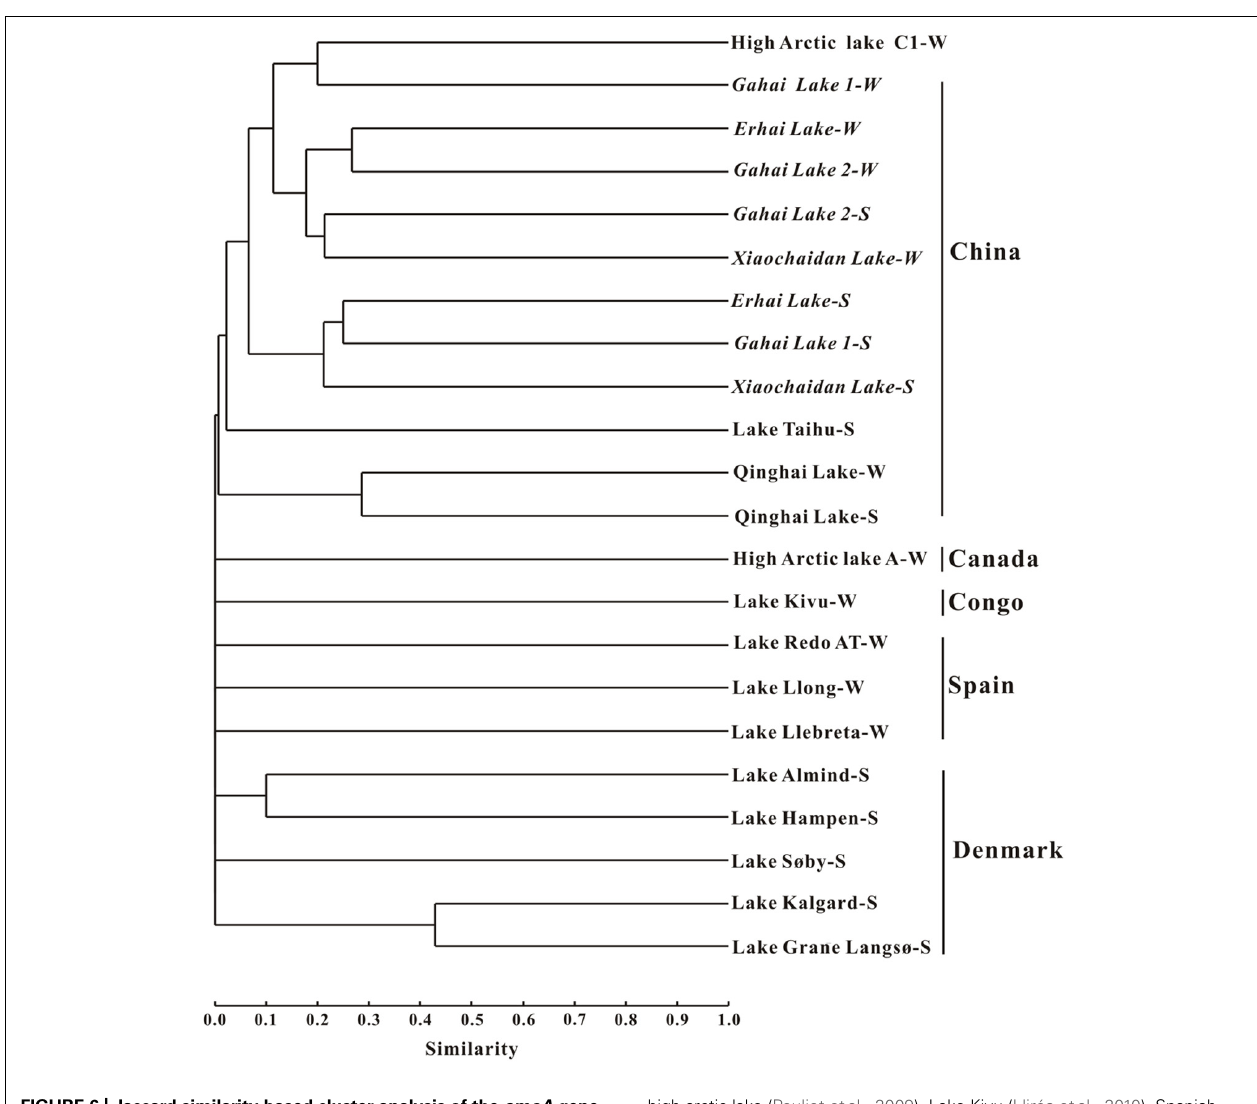
FIGURE 6 | Jaccard similarity-based cluster analysis of the amoA gene communities in different lakes worldwide. The archaeal amoA gene sequences obtained in this study were combined with those previously reported for Qinghai Lake (Jiang etal., 2009b), LakeTaihu (Wu etal., 2010),